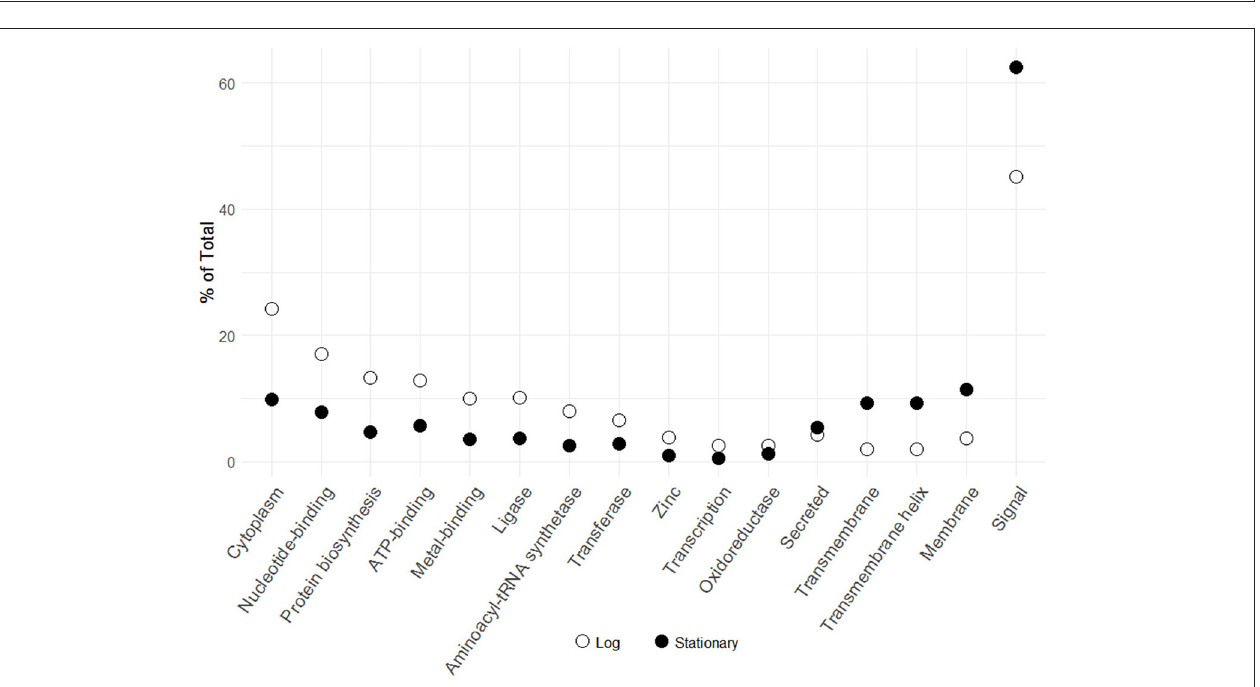
FIGURE 3 | Percent abundance of logarithmic and early stationary phase S-layer associated protein functional categories identified in Figure 2 . Functional categories were assigned via the DAVID algorithm using default parameters.